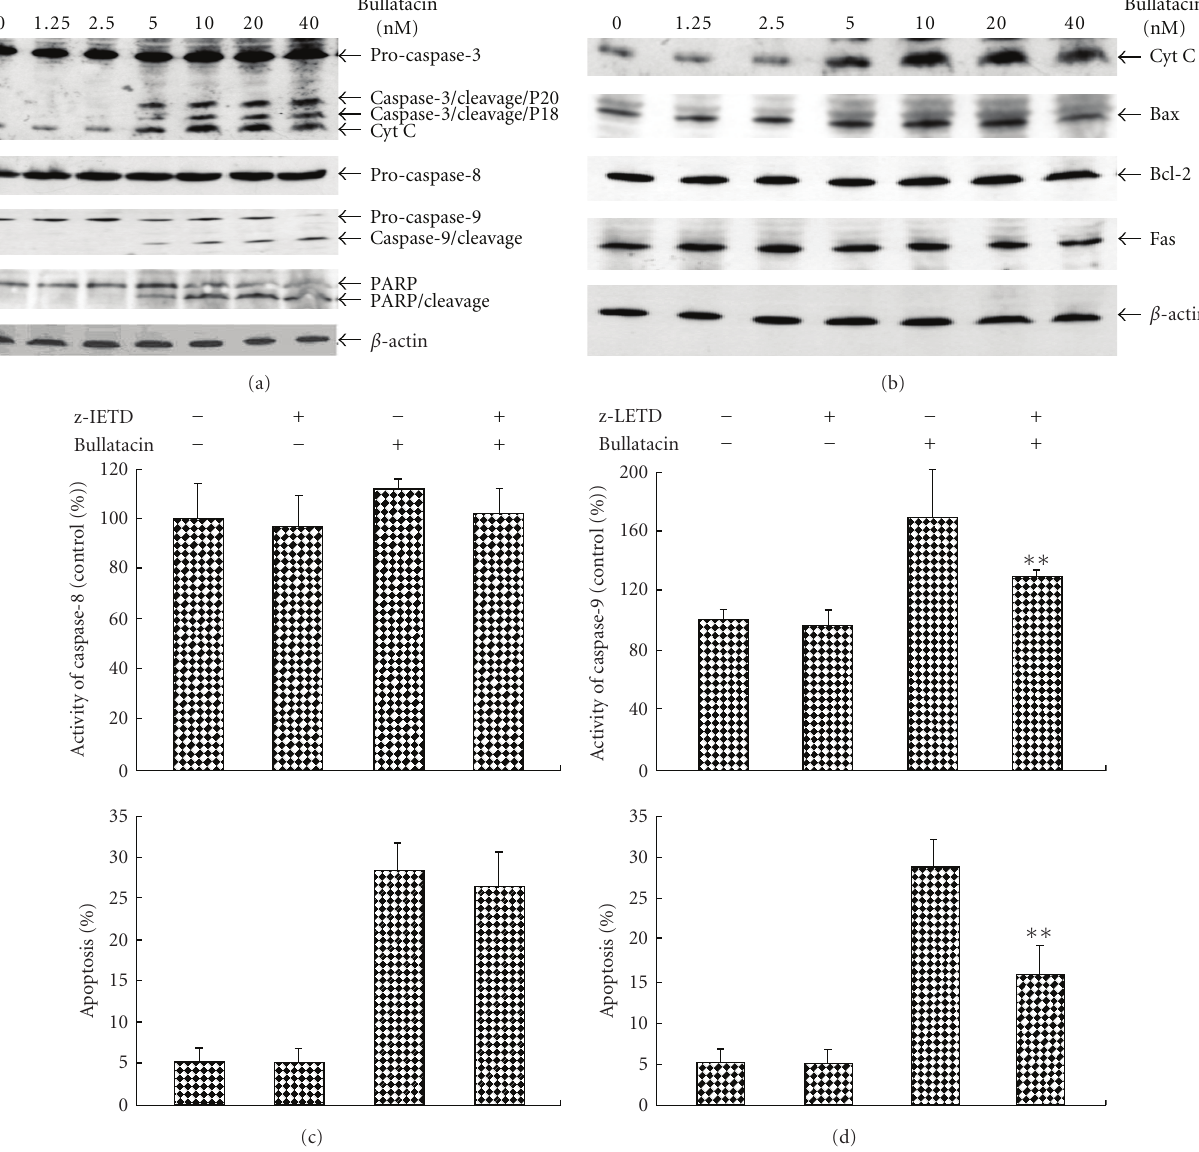
Figure 3: E ff ect of bullatacin on the release of cytochrome C from mitochondrial, activation of caspases (caspase-9, -8 and -3) and cleavage of PARP (a) and on the expression of bax, bcl-2 and Fas (b) in KBv200 cells. After incubation with bullatacin at desired concentrations for 48 h, the cellular proteins were subjected to western blot analysis. The experiments were performed three times and a representative experiment is shown; (c and d) E ff ect of bullatacin on capase-8 and -9 activation and apoptosis induction in KBv200 cells. KBv200 cells were incubated for 12 hours at 37 ◦ C in the absence or presence of caspase inhibitors, at a concentration of 10 μ M, prior to their exposure to 10 nmol/L bullatacin. 48 hours later, capase-8 and -9 activities were examined as the description of Section 2. Data represented means and standard errors of at least a triplicate